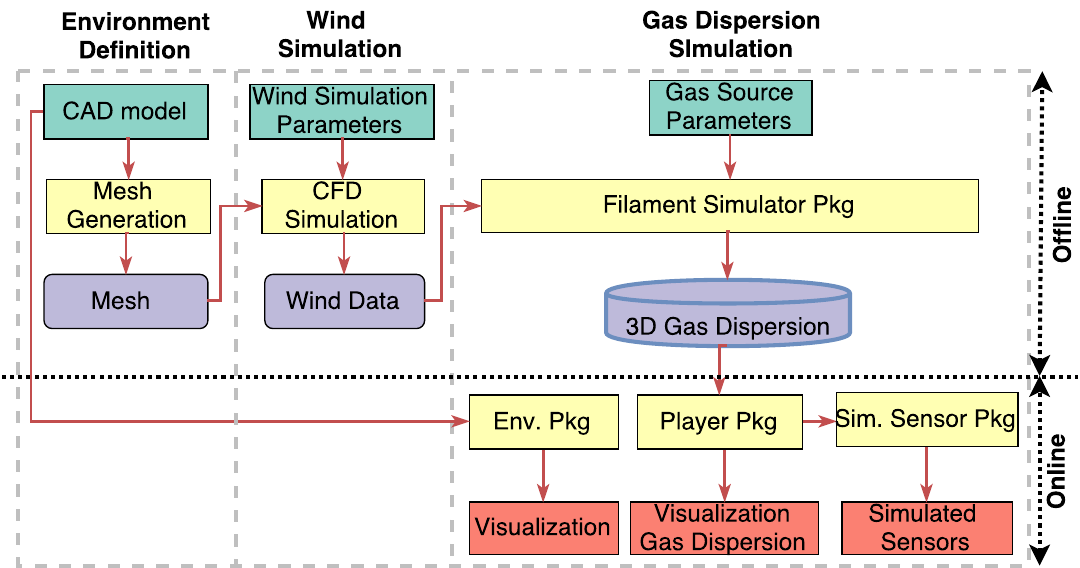
Figure 1. Block diagram of the presented gas dispersion simulator. Green, blue and red blocks represent input, intermediate and output data, respectively, while yellow blocks are